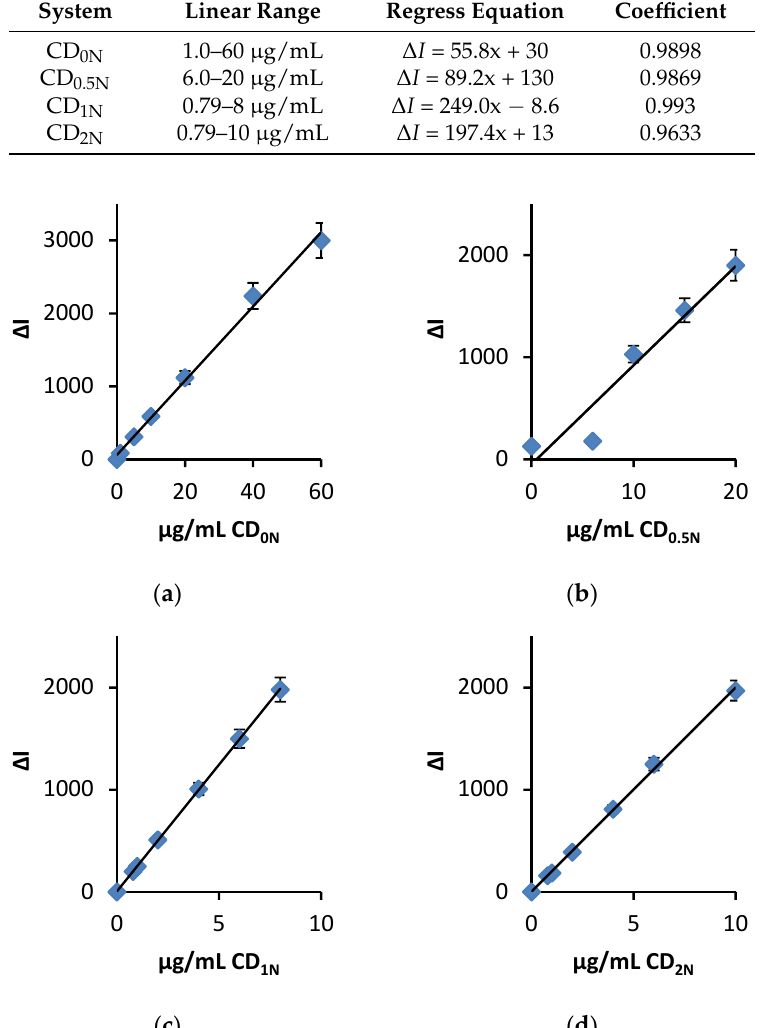
Figure 4. Relationship between the SERS intensity and CD catalyst concentration. 4.2 μ mol/L HAuCl 4 + 2.5 mmol/L H 2 O 2 + CD 0N–2N + 0.33 μ mol/L VB4R. ( a ) CD 0N ; ( b ) CD 0.5N ; ( c ) CD 1N ; ( d ) CD 2N .